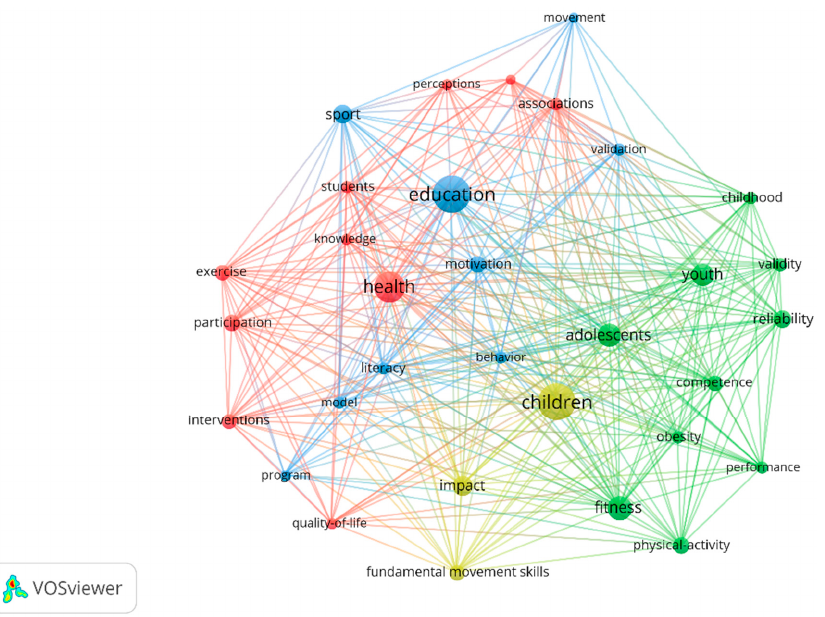
Figure 5. Keywords plus